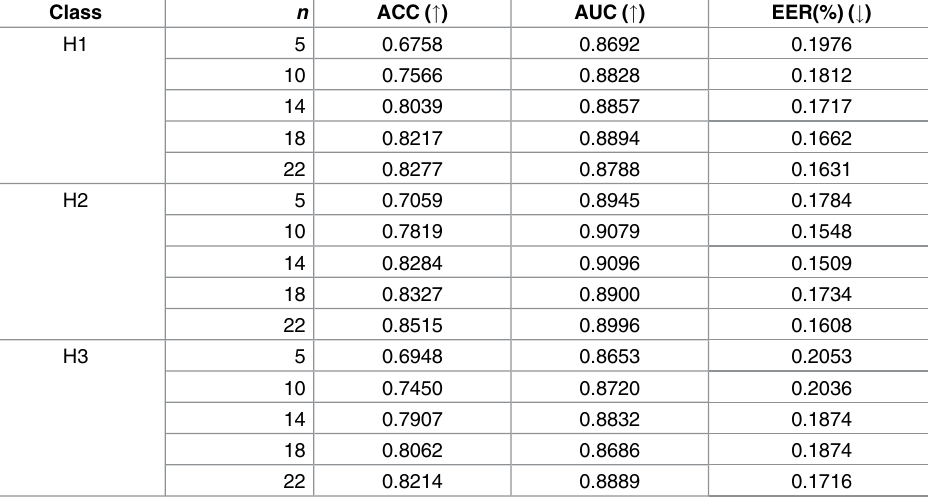
Table 3. Performance of the classification of pre-classified samples varying the number n of samples of genuine signatures used for training; same coding as in Table